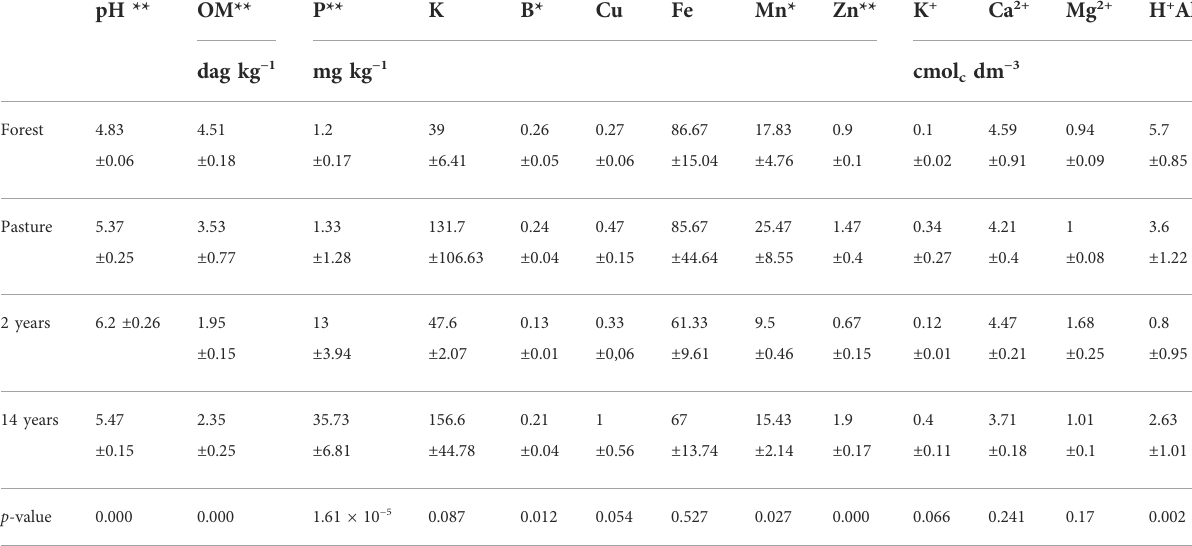
TABLE 2 Values of chemical analysis pH, organic matter, available macro, micronutrient, and soil cations at each site. pH